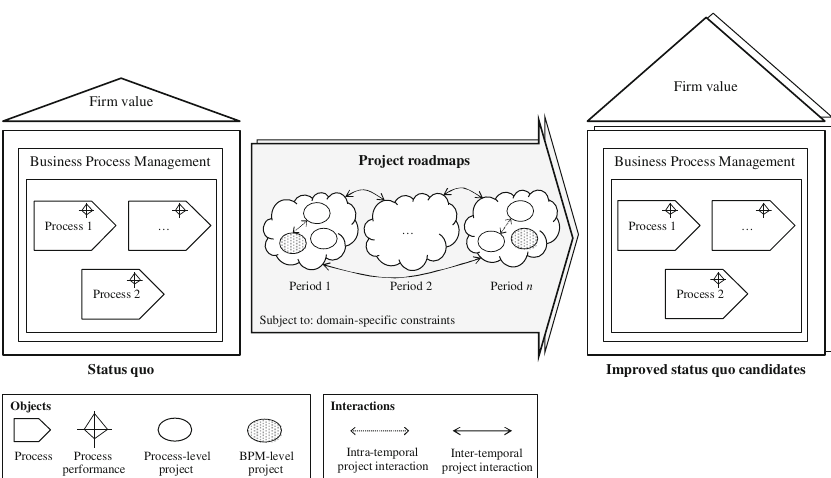
Fig. 1 Conceptual architecture of the planning model’s